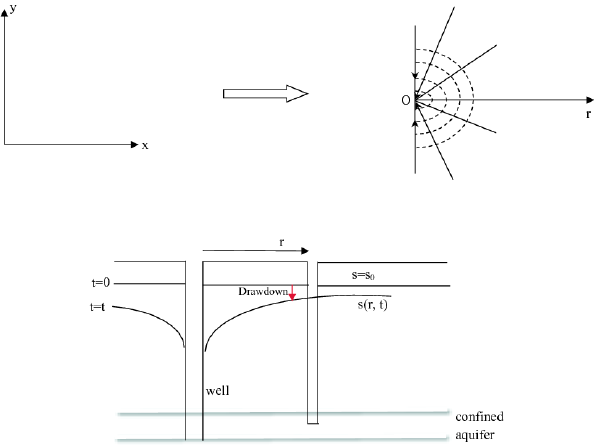
Figure 1. Radial fl ow to a well in a horizontal con fi ned aquifer. Figure 1. Radial flow to a well in a horizontal confined